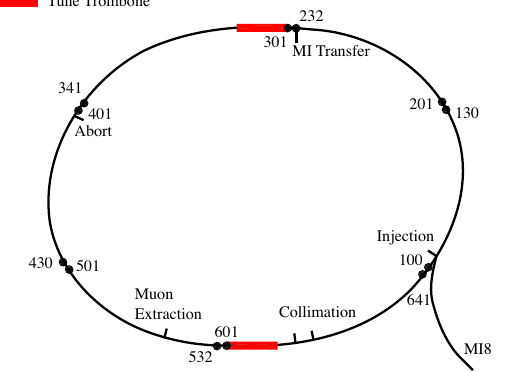
FIG. 3. A schematic of the Recycler with injection and extraction areas labeled. The collimation system was added during the 2016 summer